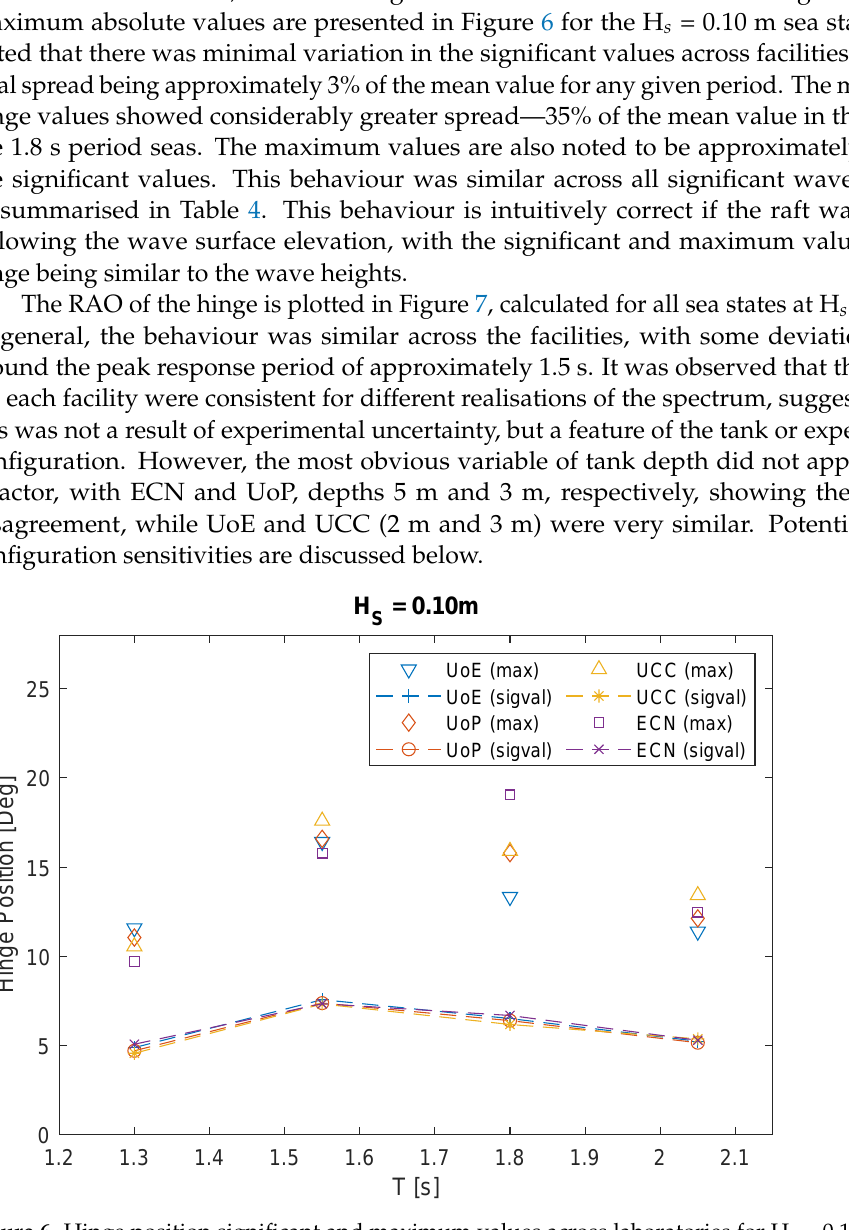
Figure 6. Hinge position significant and maximum values across laboratories for H s = 0.10